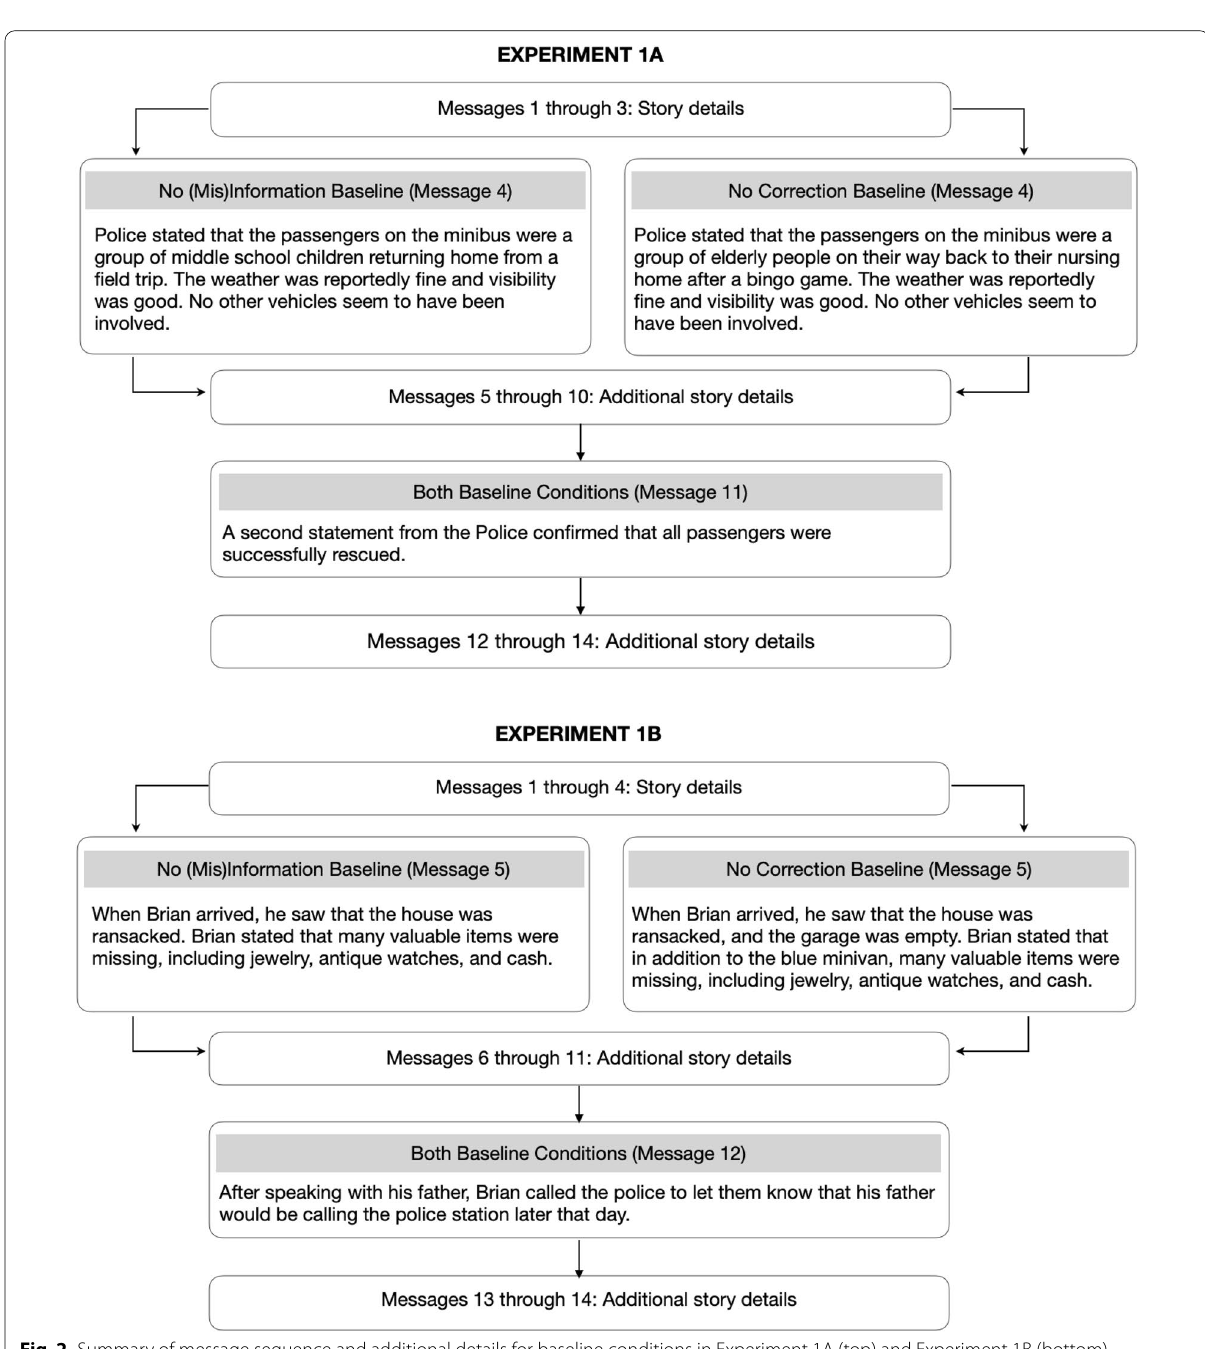
Fig. 2 Summary of message sequence and additional details for baseline conditions in Experiment 1A (top) and Experiment 1B